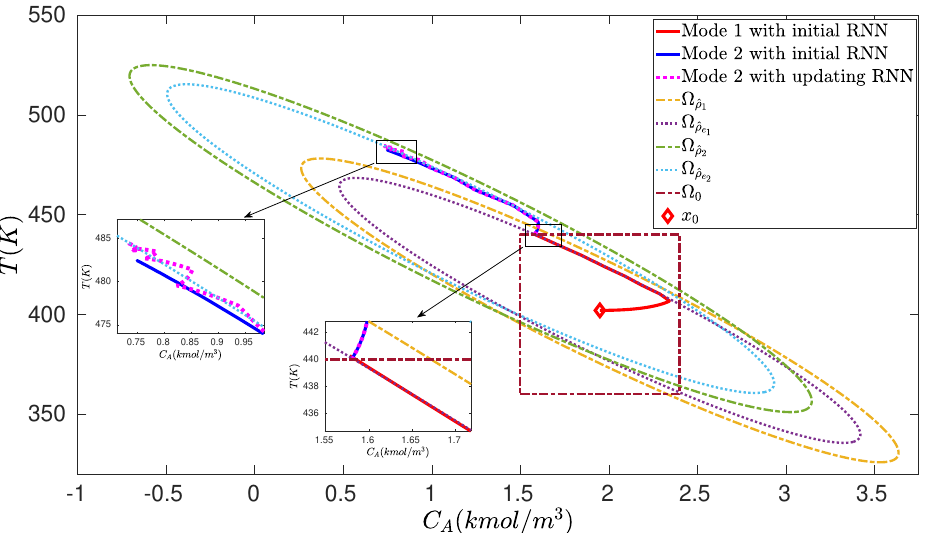
Figure 5. Closed-loop state trajectories ( C A , T ) for the nominal CSTR system operating in mode 1 for t ∈ [ 0, 0.1 h ) using the initial offline-learning RNN (red solid line), and switching to mode 2 at t = 0.1 h using the initial RNN (blue solid line) and online updating RNNs (pink dashed line) under the RNN-LEMPC of Equation (26) with the initial condition ( C A , T ) = ( 1.95 kmol/m 3 402 K ) (marked as red